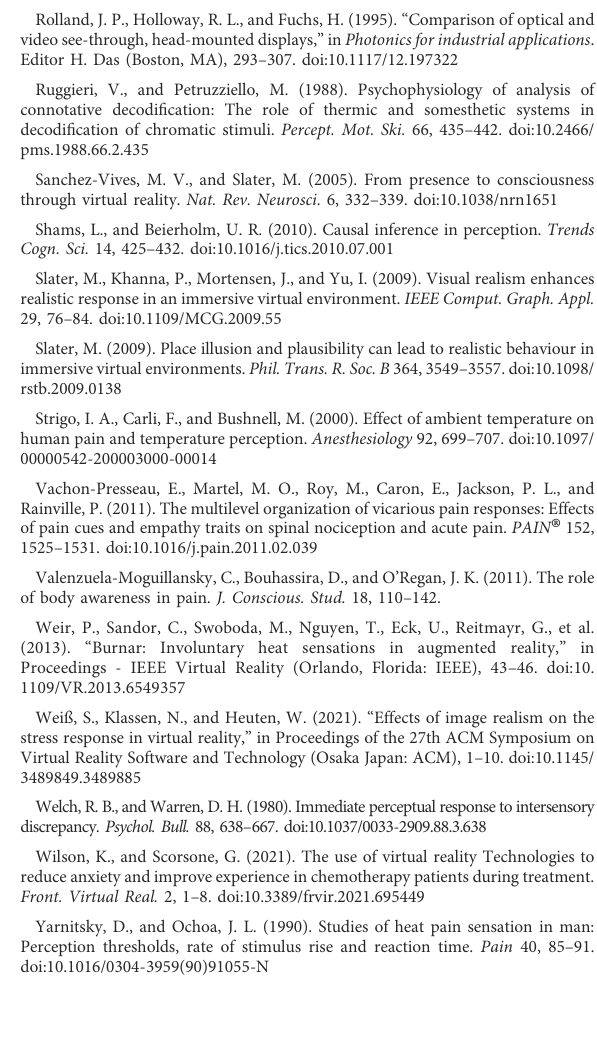
(DFNS): Standardized protocol and reference values. Pain 123, 231 – 243. doi:10.